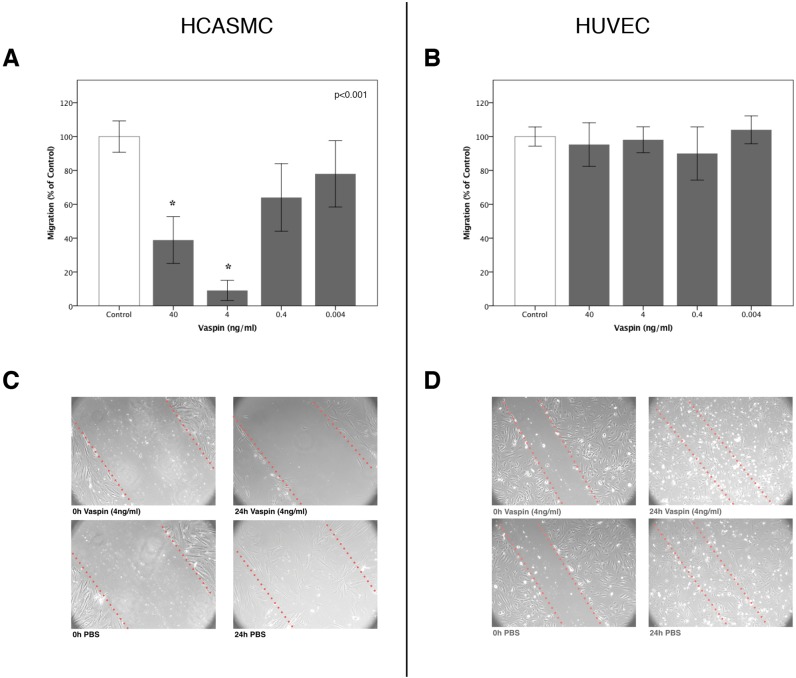
Panel A & B: Effect of vaspin on migration of human coronary smooth muscle (A), and human umbilical vein endothelial cells in vitro (B); * p<0.001. Panel C & D: Scratch assay to determine the effect of vaspin on wound healing migration of human coronary smooth muscle cells (C) and human umbilical vein endothelial cells (D) in vitro. Cells were added at a concentration of 5*10^5 cells / well. After 24h the cell monolayer was scratched in a straight line with a 200μL pipet tip. The debris of the scratch was removed by washing the cells once with growth medium and then cells were either treated with 4ng/ml vaspin (Panel A + B) or PBS as a control (Panel C + D). After 24h remigration into the scratched area was analysed under the Microscope. Each experiment was repeated 3 times and a representative sample is shown.